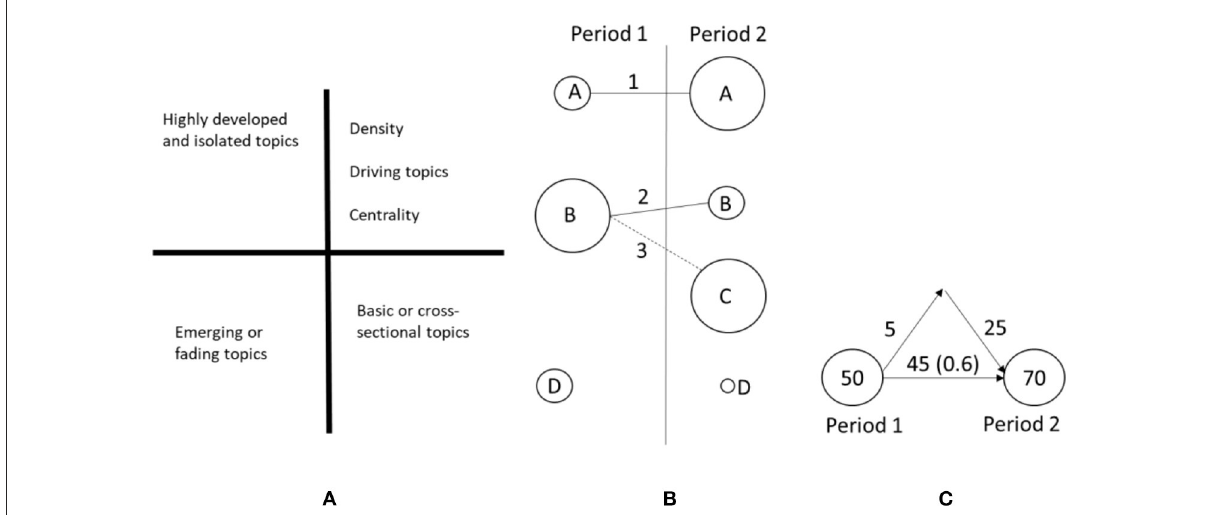
FIGURE3 Strategic diagram (A) , examples of an evolution diagram (B) , and overlap diagram (C)